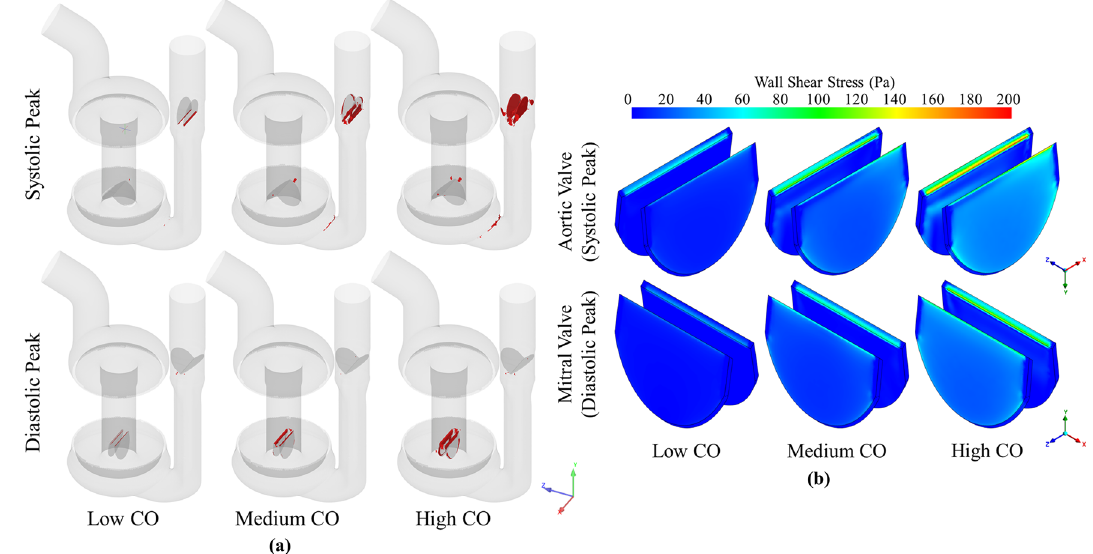
Figure 8. ( a ) Volume of fluid that exceeds the threshold scalar shear stress value of 17.5 Pa at systolic and diastolic peak scalar shear stress time points and ( b ) wall shear stress distribution of aortic valve at systolic peak scalar shear stress, and mitral valve at diastolic peak scalar shear stress time points for low (60 bpm 19 mm), medium (100 bpm 21 mm) and high (120 bpm 25 mm) CO, equating to 3, 5 and 7